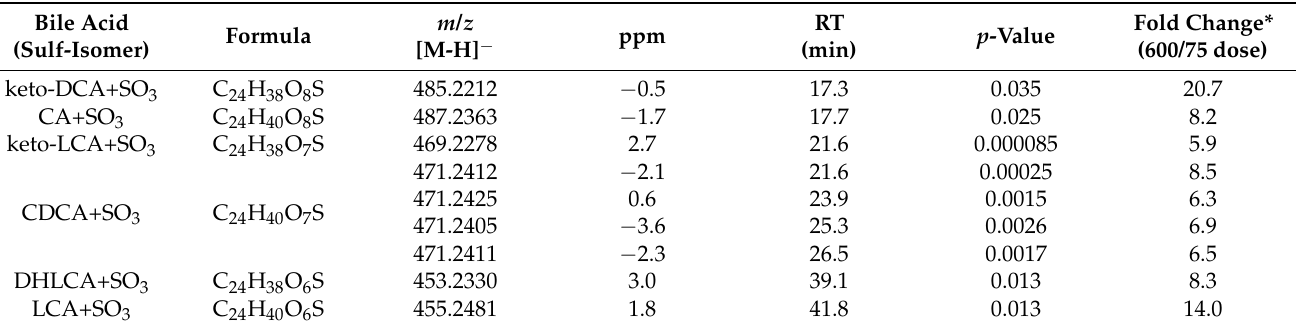
Figure 4. Peak area ratios of tentatively assigned sulfate conjugates having significant changes between 75 and 600 mg/kg APAP dose. Statistical significance is shown with p -value <0.05 (*), <0.01 (**), or <0.001 (***). Table 2. Tentatively assigned sulfate conjugates with significantly changing peak area ratios in rat plasma between low and high APAP doses.